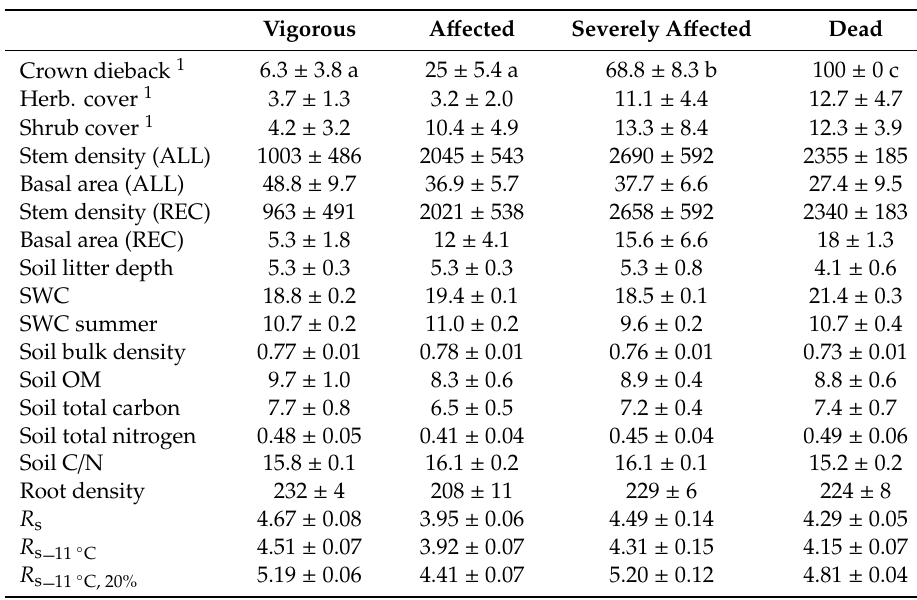
Table 1. Characterization of the four types of plots established around centennial beech trees of di ff erent declines–vigorous, a ff ected, severely a ff ected–and dead. Crown dieback of the centennial beech tree (%); cover of herbaceous (Herb.) species (%) and cover of shrub species (%); stem density (stems ha − 1 ) and basal area (m 2 ha − 1 ) of either all trees in the plot (ALL) or only saplings > 1.5 m height and < 0.5 m diameter at breast height (i.e., of recruits established after the woodland was banned to cattle grazing in the 1960s; REC); fine litter depth (i.e., leaves and small twigs; cm); soil water content over 0–20 cm topsoil (SWC; %) averaged for all or only summer measurement dates, and soil bulk density (g cm − 3 ), organic matter (OM; %), total carbon (C, %), total nitrogen (N, %), C to N ratio, and fine root density ( < 2 mm; g m − 2 ) of 0–10 cm topsoil; average soil respiration measured across two years ( R s ; µ mol m − 2 s − 1 ), and modeled at mean annual soil temperature (11 ◦ C), and constant temperature and soil water content (20%). Data are means ( ± SE) from four replicate plots per tree decline class. Di ff erent letters separate significantly di ff erent means of crown dieback, the only variable for which significant di ff erences among tree classes were found at p < 0.05.